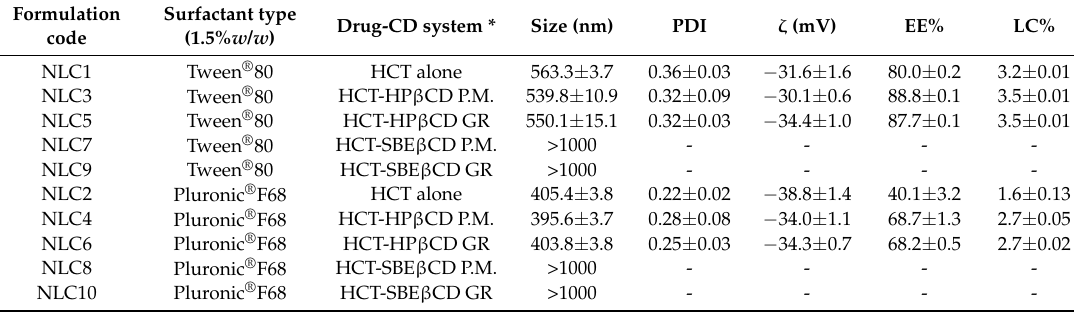
Table 1. Composition of the different NLC formulations, all containing Precirol ® ATO5 as solid lipid and castor oil as liquid lipid (90:10 w / w ratio) and their properties in terms of mean size, polydispersity index (PDI), Zeta potential ( ζ ), Encapsulation Efficiency (EE%) and Loading Capacity